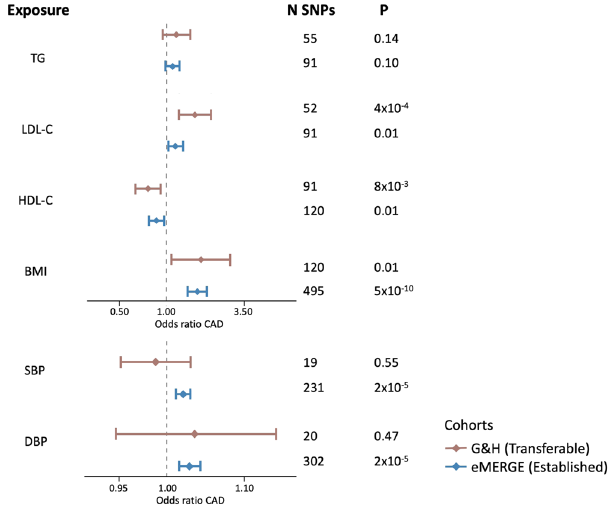
Fig. 5 | Mendelian randomisation estimates of risk factors on coronary artery disease in European (eMERGE) and British South Asian (G&H) ancestry indivi- duals. Two-sample Mendelianrandomisation (MR) estimates for the causaleffects arepresentedbasedongeneticinstrumentvariablesidenti fi edfromEURdiscovery GWASforeachriskfactor.Allindependentgenome-widesigni fi cantlociwereused asinstrumentsforeMERGEandonlythetransferablelociforG&H.Effectestimates are presented as odds ratios with 95% con fi dence intervals per standard deviation increaseinthe reported unitofthetrait:triglycerides (TG),systolicblood pressure (SBP), low-density lipoprotein cholesterol (LDL-C), high-density lipoprotein cho- lesterol (HDL-C), diastolic blood pressure (DBP), body mass index (BMI). The two- sided p -value ( P ; not adjusted for multiple comparisons) and the number of single nucleotide polymorphism instruments (N SNPs) included in the MR analysis are shownfor each exposure. GWASfor CAD was performed in n =22,008 (1110cases) samples from G&H, and n =32,816 (6815 cases) unrelated samples from eMERGE.